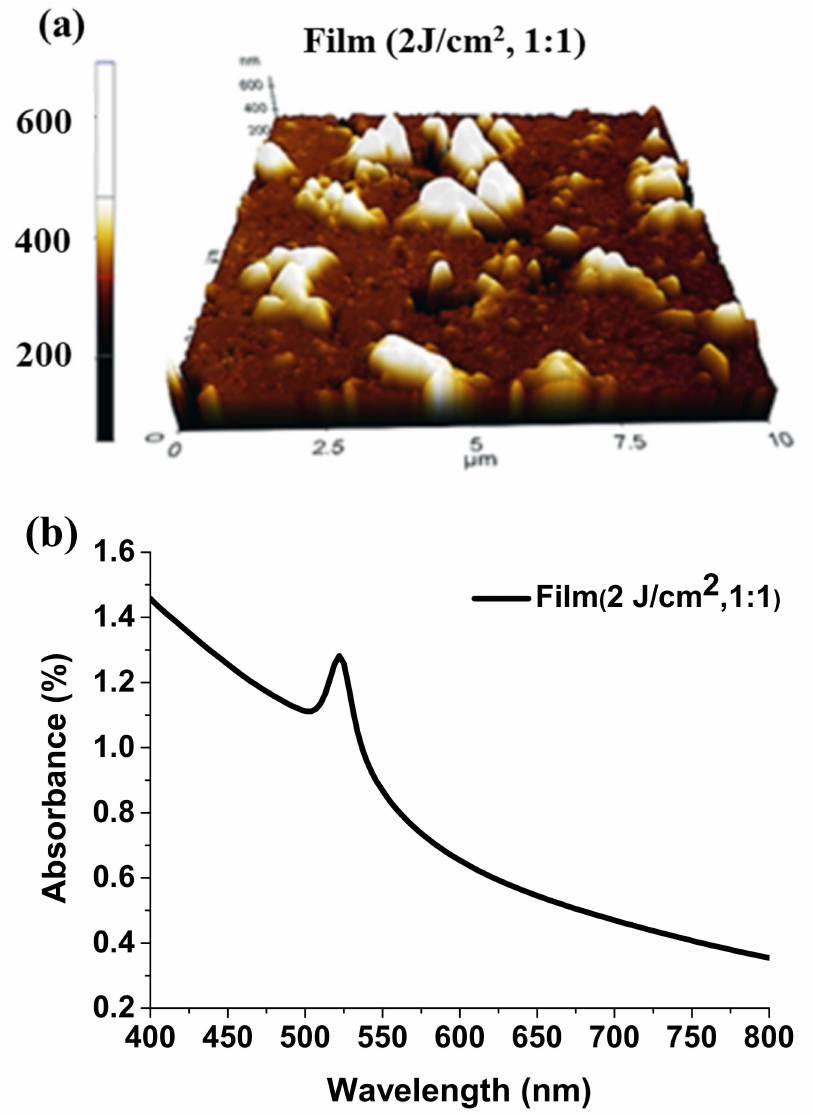
Figure 8. Topographical and optical information on Film (2 J/cm 2 , 1:1). ( a ) 3D AFM topography measured over a scan area of 10 × 10 µ m 2 . ( b ) Absorbance